Question: Summarize what this figure shows in one sentence.
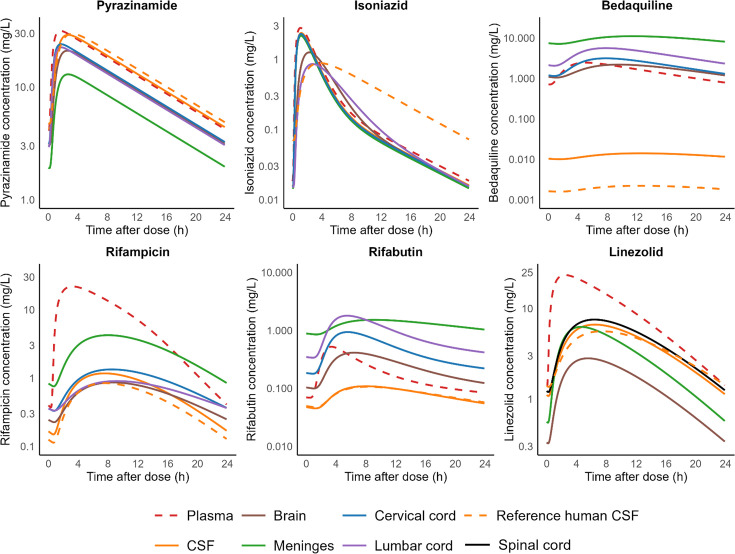
Answer: Simulated concentration–time profiles of pyrazinamide, isoniazid, bedaquiline, rifampicin, rifabutin, and linezolid in plasma, CSF, and CNS tissues of a typical TB patient (male, 55 kg). Dashed lines represent simulations informed by previously published pharmacokinetic models based on human data, whereas solid lines represent interspecies-scaled profiles extrapolated from rabbit experiments.